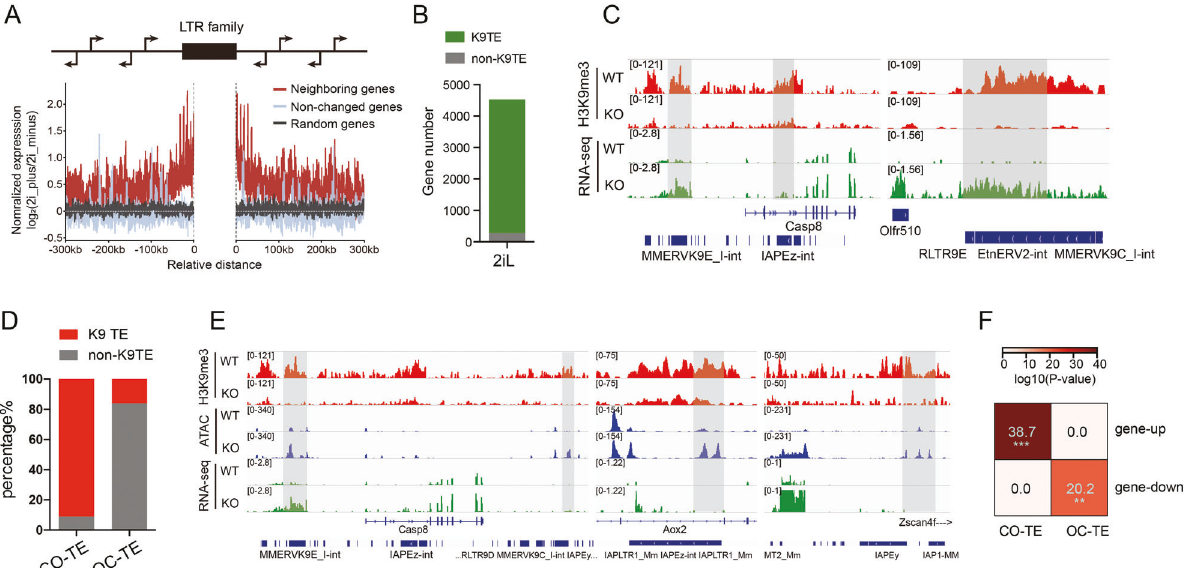
Fig. 2 H3K9me3 marked TEs display a cis-regulatory effect. A Line plot showing the expression trends of neighboring genes within 300 kb of LTR family, expression non-changed genes and random genes act as a control. B Histogram displays gene number nearby H3K9me3 marked-TEs and non-H3K9me3-marked TEs in 2iL condition. C IGV graphs illustrate H3K9me3 occupancy in Setdb1 WT and KO mESCs in 2iL culturing condition, together with RNA-seq in 2iL culturing conditions at Mmp10 and Olfr510 with their nearby TEs. D Column graphs shows percentage of K9/non-K9-marked TEs in CO/OC-TE. E IGV graphs illustrate H3K9me3 occupancy in Setdb1 WT and KO mESCs in 2iL culturing condition, together with RNA-seq and ATAC-seq in 2iL condition at Casp8 , Aox2 , Zscna4f with their nearby TEs. F A heatmap displays CO/OC- TEs and their nearby up/down regulated genes. Signi fi cance is derived from a Fisher exact test (* p < e-10; ** p < e-20; *** p <